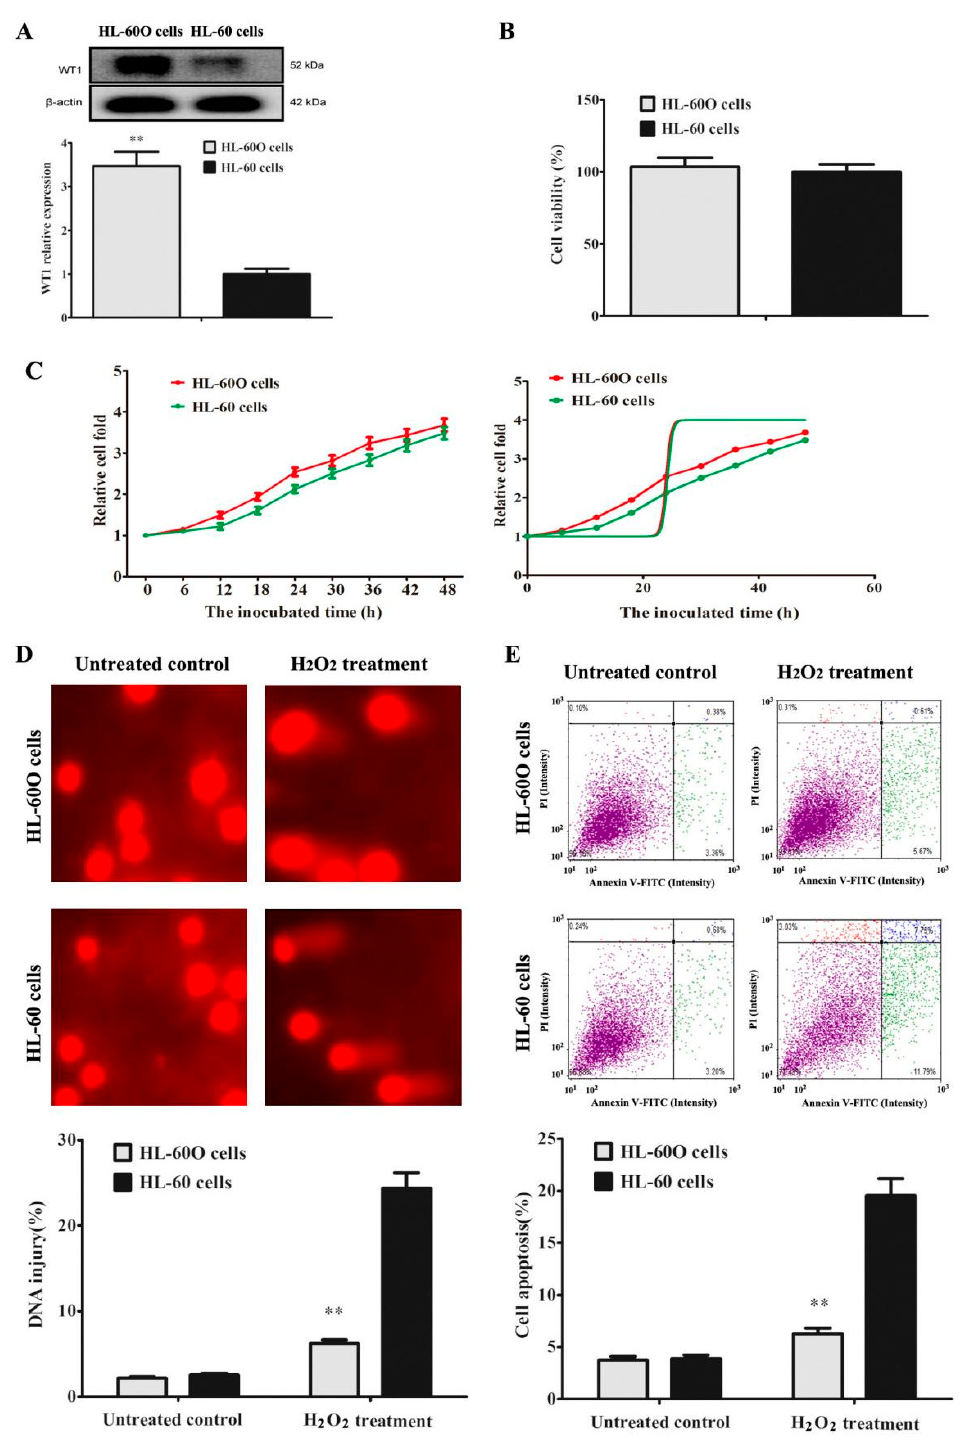
Figure 1. WT1 over-expression promotes HL-60 cell resistance to H 2 O 2 . ( A ) WT1-overexpressed HL-60 cells (HL-60O cells) were established by Lentivirus transfection, and WT1 expression was detected by Western blot ( n = 3). The equivalent cells were incubated for 48 h. ( B ) Cell viability was detected by MTT assay ( n = 6). ( C ) Relative cell fold was detected by MTT assay. Cells were treated with 100 μ M H 2 O 2 for 24 h. ( D ) DNA injury was indicated by the percentage of tail DNA in total DNA in Comet assay ( n = 3). ( E ) Cell apoptosis was tested by Annexin V-FITC/PI dual staining in flow cytometry ( n = 3). The data were presented as the mean ± SD. ** p < 0.01 compared to the parent HL-60 cells.